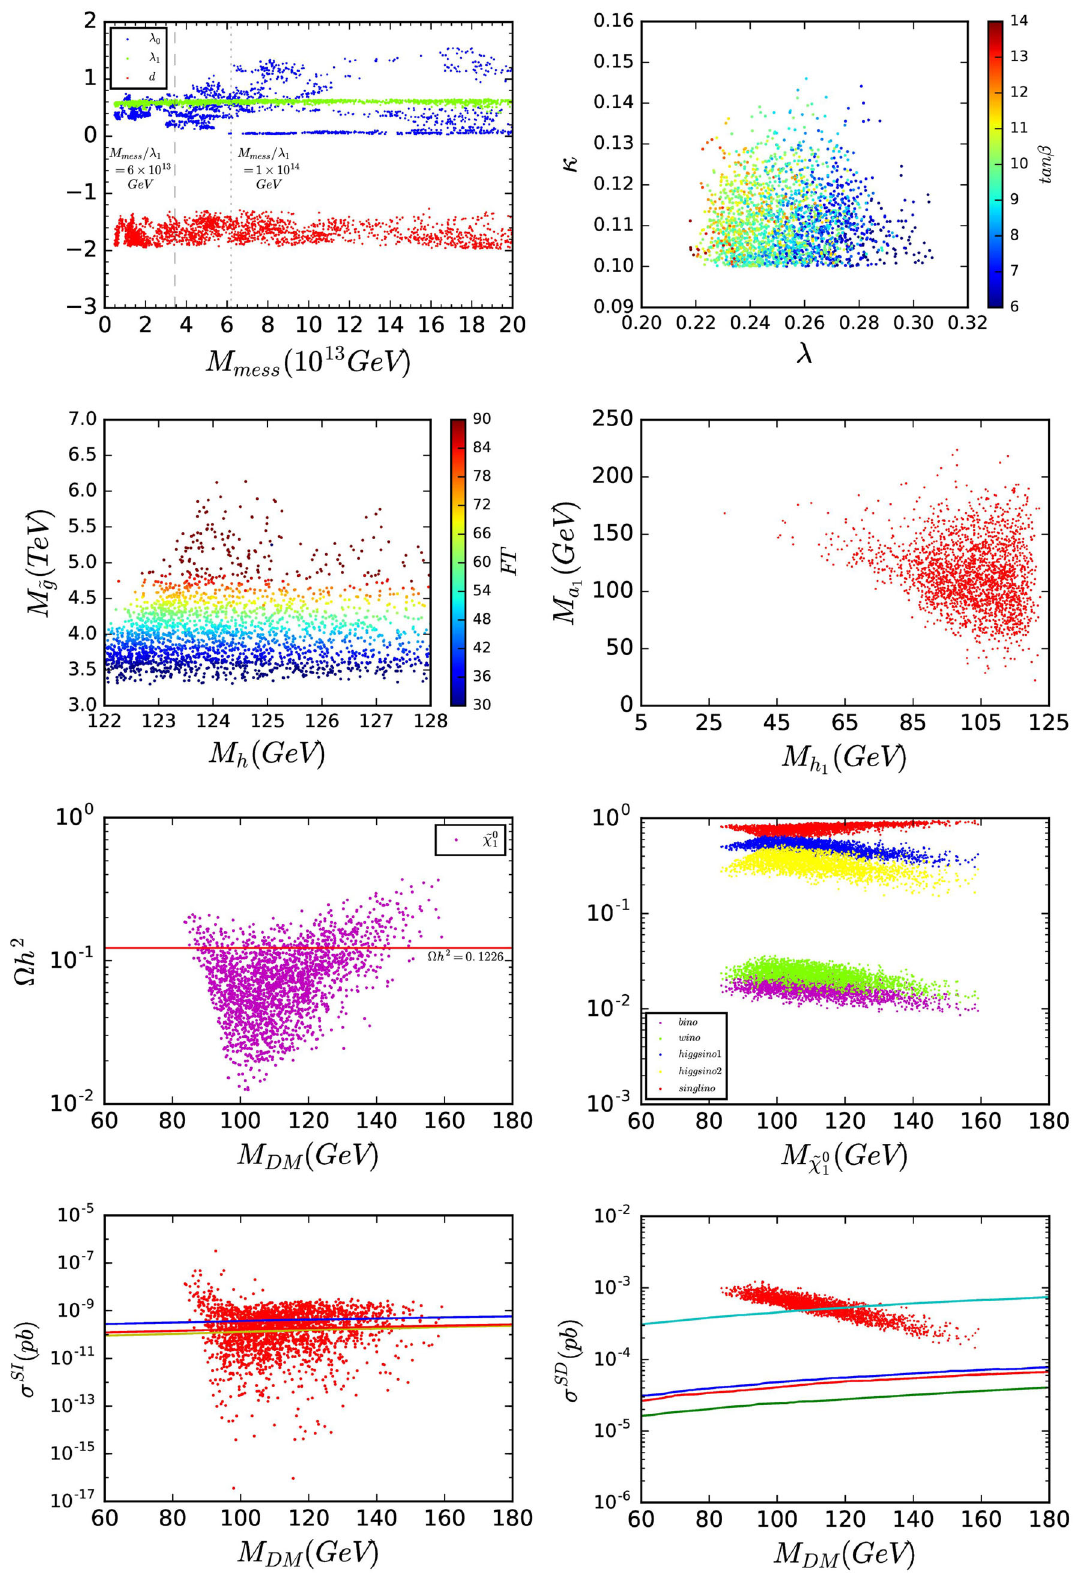
Fig. 4 Survived points that can satisfy the EWSB conditions and the constraints from (I) to (IV) in the case the 125 GeV Higgs is the next- to-lightest CP-even scalar in AMSB scenario. Other notations are the